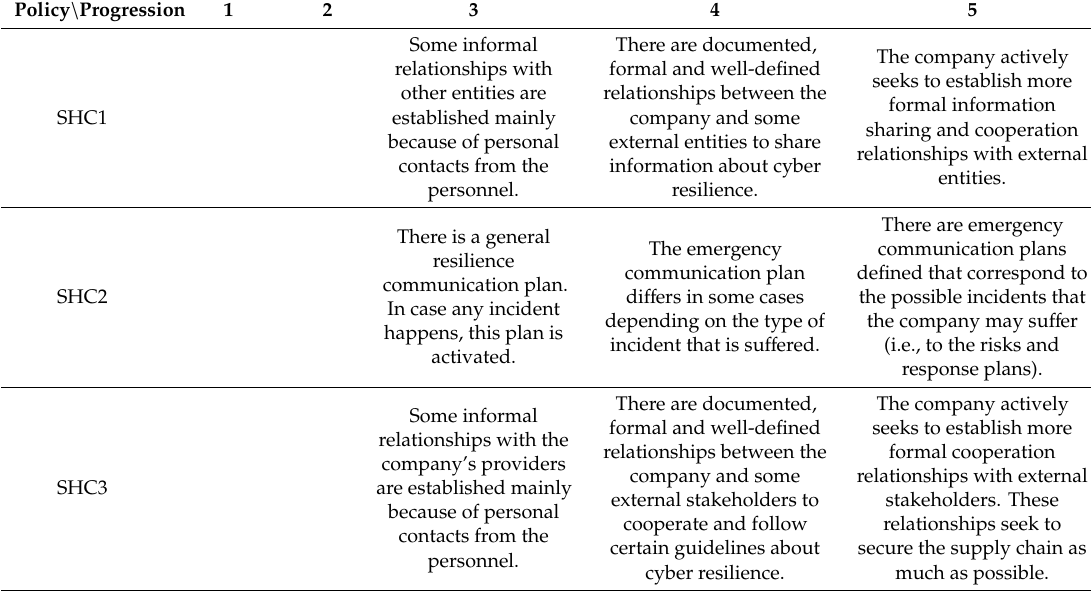
Table 31. Information sharing and communication policies’ progression